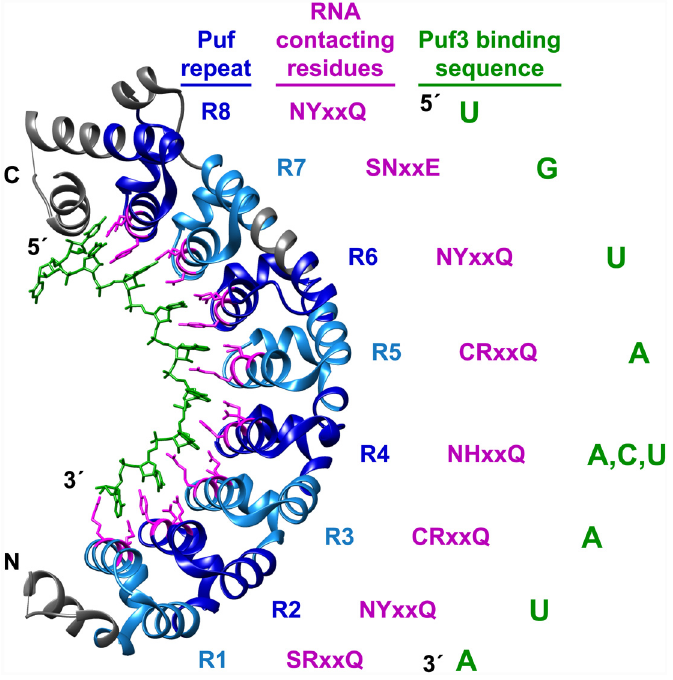
Fig 1. Puf3 recognition of RNA. S . cerevisiae Puf3 structure displayed as a ribbon model from PDB (Protein Data Bank) entry 3k49 [49]. The RNA molecule with sequence CCUGUAAAUA is indicated in green. Puf repeats are highlighted in alternating light and dark blue. The Puf proteins with the same RNA-base- contacting amino acids as Puf3 (pink) that have been studied have a conserved RNA binding specificity [24,25,27,29,50,51]; the Puf proteins with different RNA-base-contacting amino acids have different RNA binding specificities [25,31,51 – 55]. The conserved RNA binding sequence is eight nucleotides, containing UGUA at the 5' end, flexibility for A, C, or U at the 5th position, and AUA at the 3' end. Mutating the RNA- interacting amino acids alters RNA binding specificity and can be done to make predictable changes in sequence specificity [51,56 – 59]. S . cerevisiae Puf3 contains additional residues that contact a nucleotide upstream of the core binding sequence, but these interactions are not conserved across